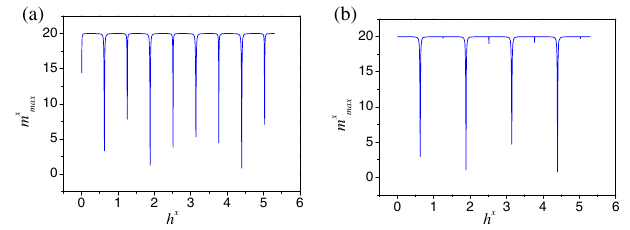
FIG. 3. Plots of the maximum expectation value of S x versus h x , for S ¼ 20 ; T ¼ 10 ; h z ¼ 1 , and (a) h x 12 . 8 π ≃ 40 . 212 . In panel (a), we see pronounced dips for h x equal to all integer multiples of 2 π =T , while in panel (b) we see pronounced dips only when h x is equal to odd integer multiples of 2 π =T , as predicted by the FDPT result, Eq.